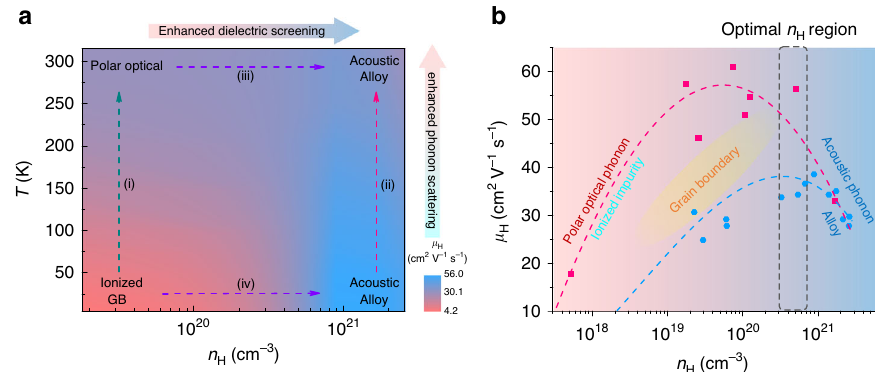
Fig. 5 Carrier scattering phase diagram for ZrNiSn-based half-Heusler compounds. a The phase diagram as functions of temperature and carrier concentration. GB represent grain boundary scattering. b The phase diagram with single-crystalline and polycrystalline data as function of carrier concentration at 300 K. The dash lines in the fi gures are guides of